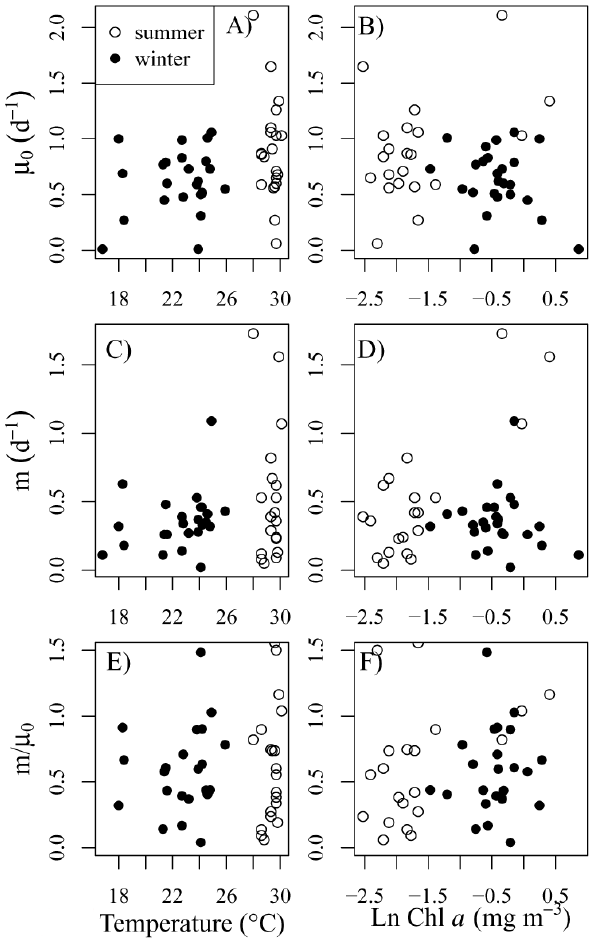
Fig. 8. Relationships of (A, B) µ 0 , (C, D) m , and (E, F) m / µ 0 with temperature and ln Chl a concentrations in surface